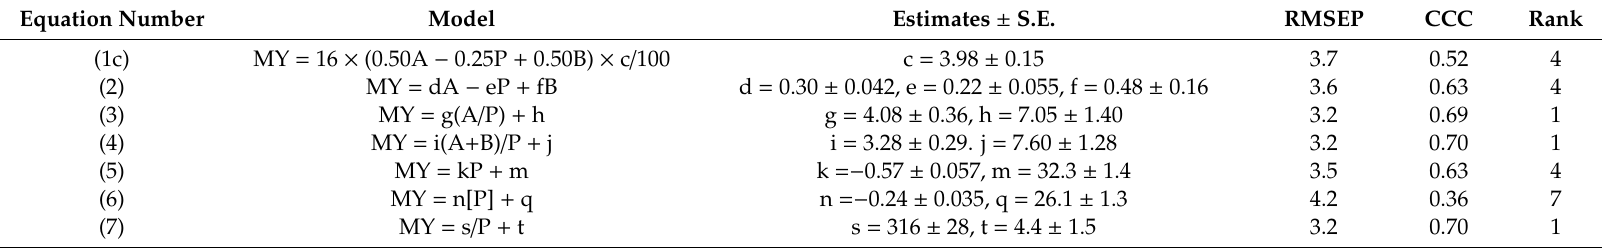
Table 5. Seven models, used to predict methane yield (MY, g methane / kg dry matter intake) from ruminal acetate (A), propionate (P), and butyrate (B) expressed as the models to training data, pooled from seven experiments by meta-analysis. Root-mean-square error of prediction (RMSEP, g CH 4 / kg dry matter intake) and Lin’s concordance (CCC) were calculated by a leave-one-experiment-out cross-validation procedure. These were used to calculate rank (1 = minimum RMSEP, maximum CCC) of equations